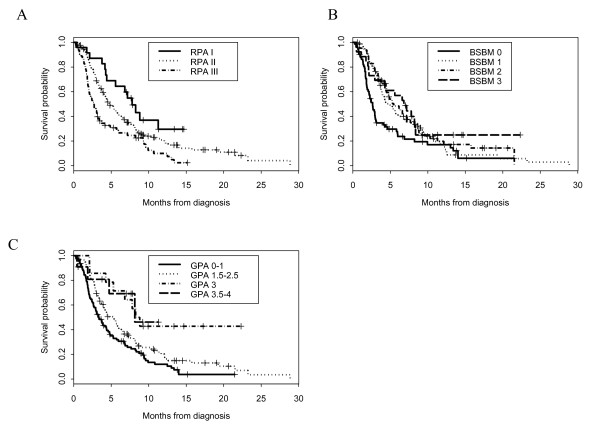
Actuarial survival curves according to Recursive Partitionning Analysis (A), Basic Score for Brain Metastases (B) and Graded Prognostic assessment (C) class of patients.